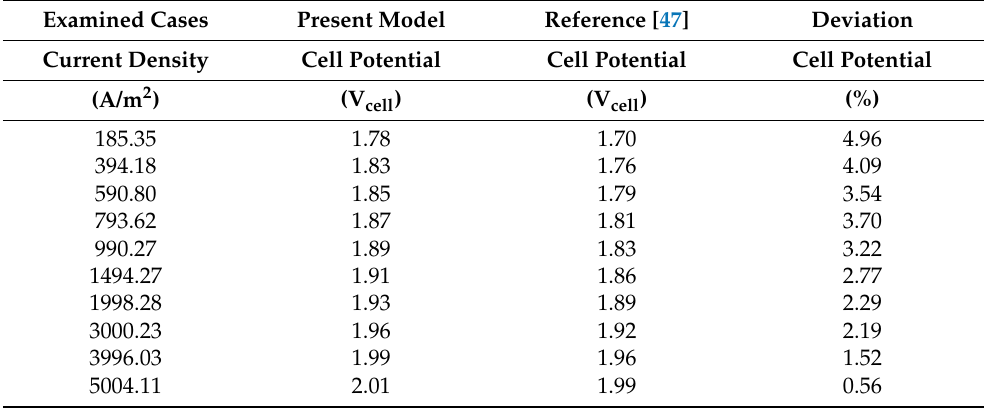
Table 6. Validation of the PEM water electrolyzer with experimental data from the